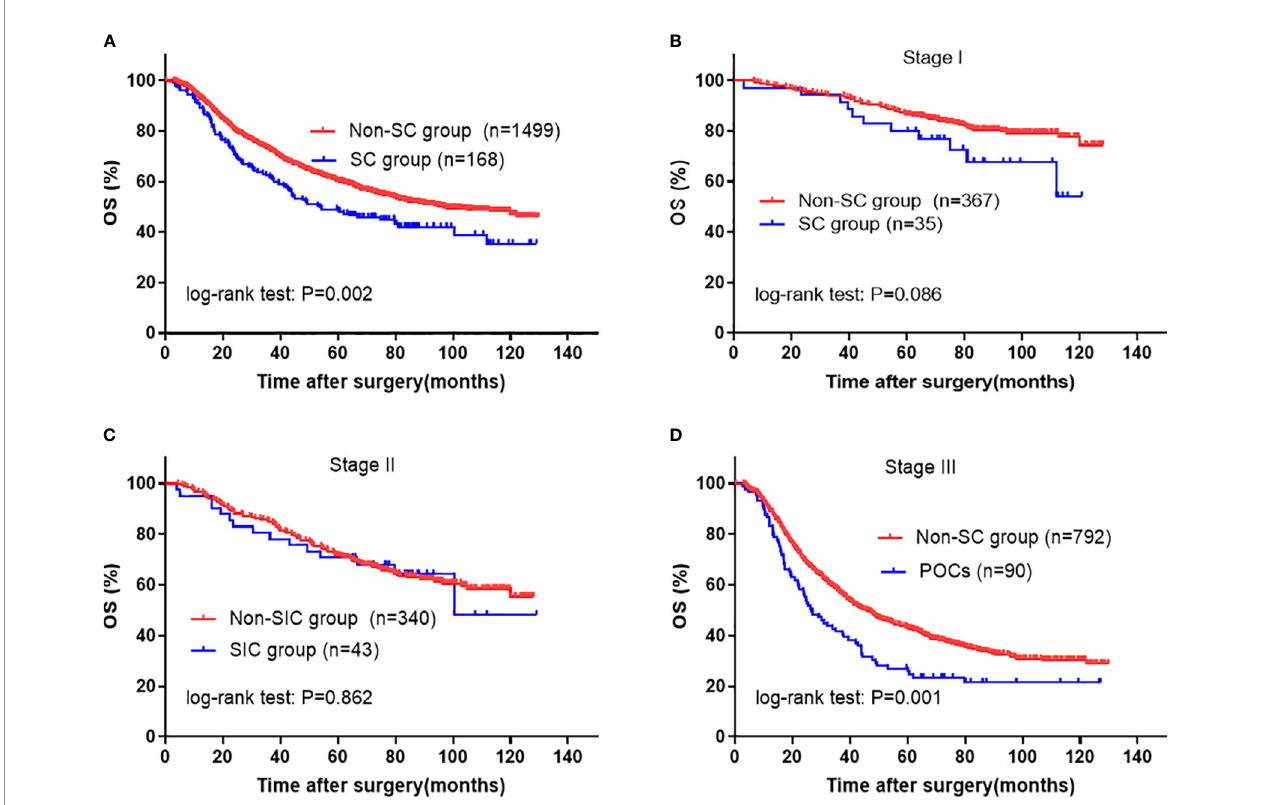
FIGURE 2 | Kaplan-Meier survival analysis of SC in entire cohort. (A) in all patients; (B) in Stage I, (C) in Stage II, and (D) in Stage III patients. The signi fi cance of the difference between survival curves was calculated by the log-rank test. SC, severe complication.